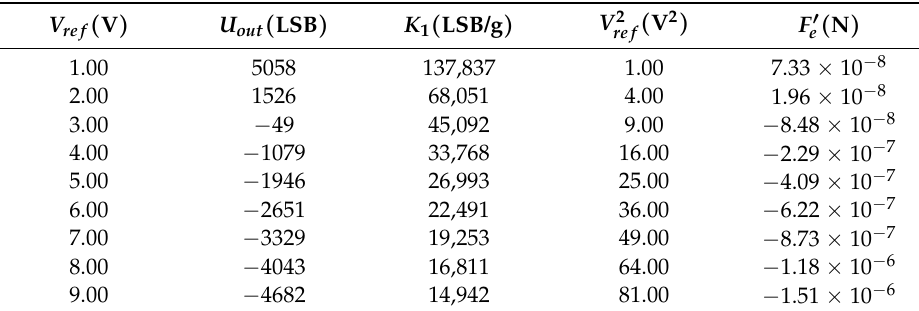
Table 1. The measuring data with different V ref .